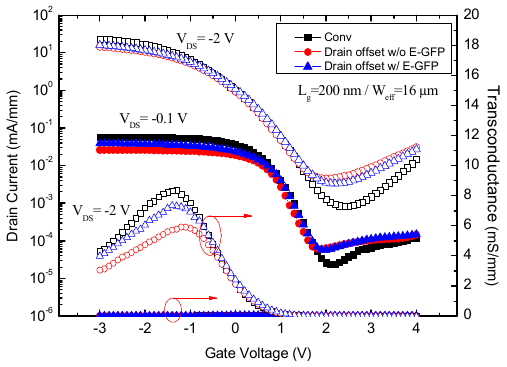
Figure 4. Transfer curves of JL FinTFT for conventional JL FinTFT, drain offset JL FinTFT without E − GFP, and drain offset JL FinTFT with E − GFP. Table 2. Electrical parameters of the JL FinTFTs with various structures. Figure 5a plots the off-state and on-state breakdown voltage of JL FinTFTs. The off-